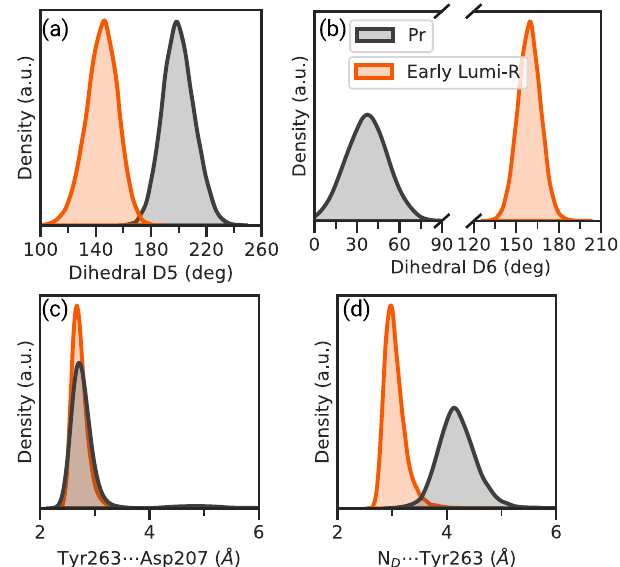
Fig. 4 | Early Lumi-R intermediate. a , b Distribution for the dihedrals D5 and D6, respectively; c , d Distribution for the Tyr263 ⋯ Asp207 and N D ⋯ Tyr263 dis- tances, respectively. The distributions were made on the QM/MM (orange) and Pr (black) MDs. A representative structure of the early intermediate can be found in Fig. 1. Source data are available in the Zenodo repository 89